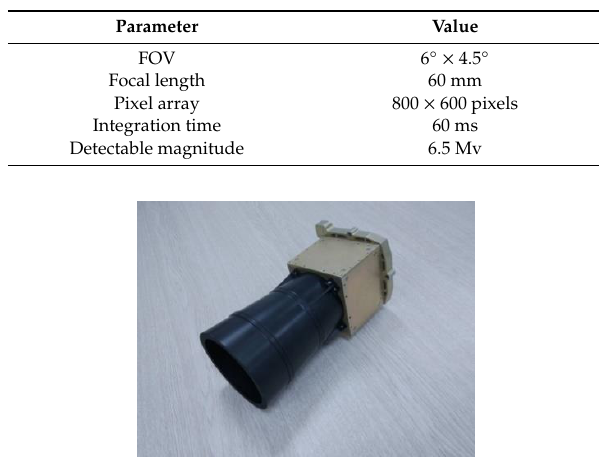
, the star image in Figure 10a is blurred